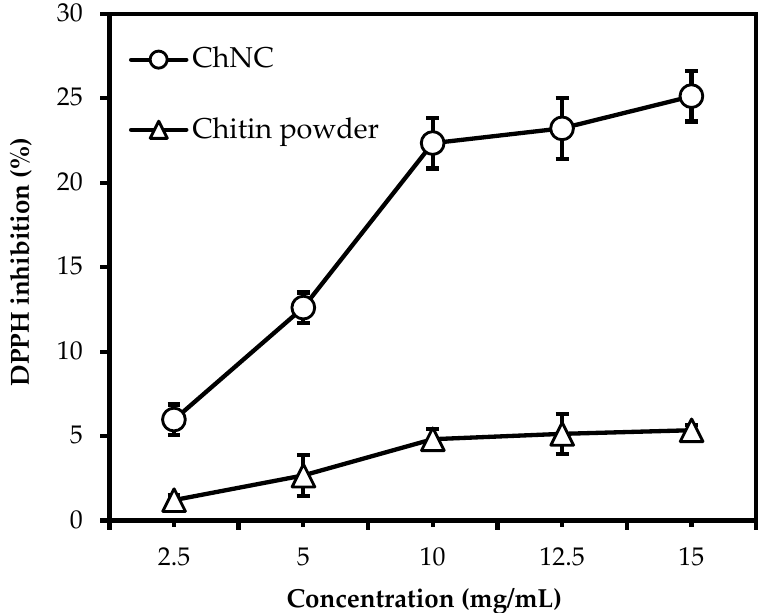
Figure 1. DPPH inhibition by ChNC (o) and chitin powder ( Δ ) for different concentrations.